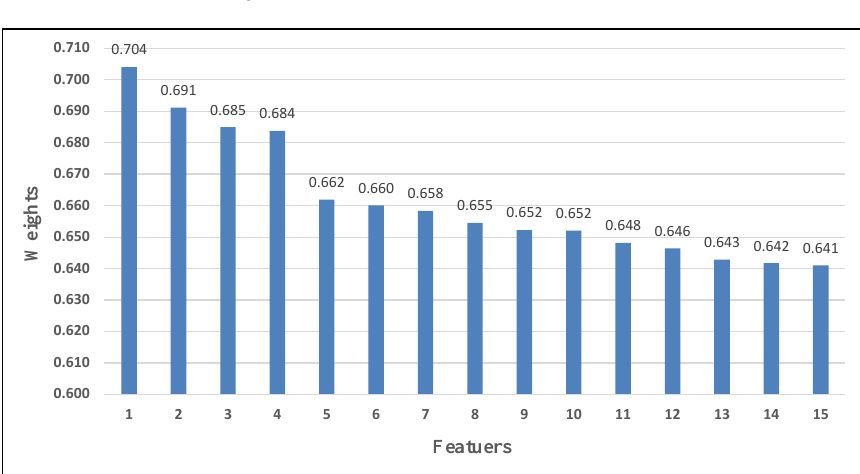
Figure 7. WOA-SVM weights for the features of Data